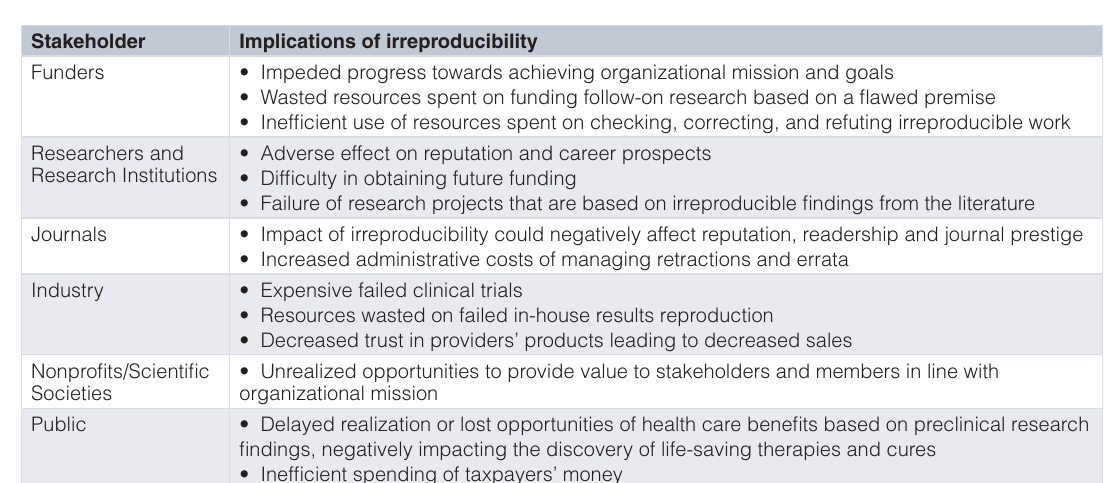
Table 2. Reproducibility affects all stakeholders in preclinical life sciences